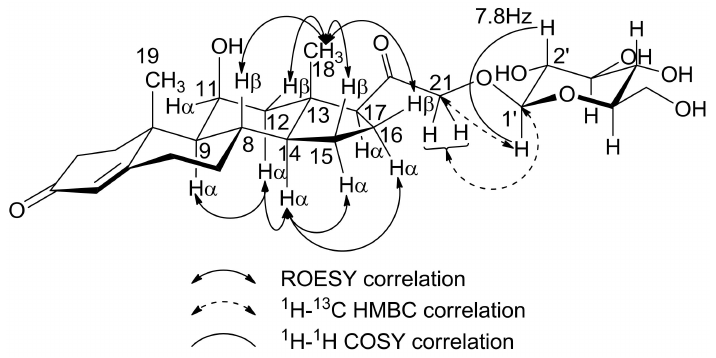
Figure 4. Corticosterone 21-glucoside shape and 1 H- 1 H correlation of NOE for stereochemistry confirmations at H-9, H-14 and H-18 are determined ROESY. In addition, the glucose linkage position with corticosterone was indicated by the investigation of 1 H- 13 C long-range coupling correlation using 1 H- 13 C HMBC experiment. The determination of the glucose moiety anomericity was presented by the elucidation of 1 H- 1 H COSY and 1 H- 13 C HMBC